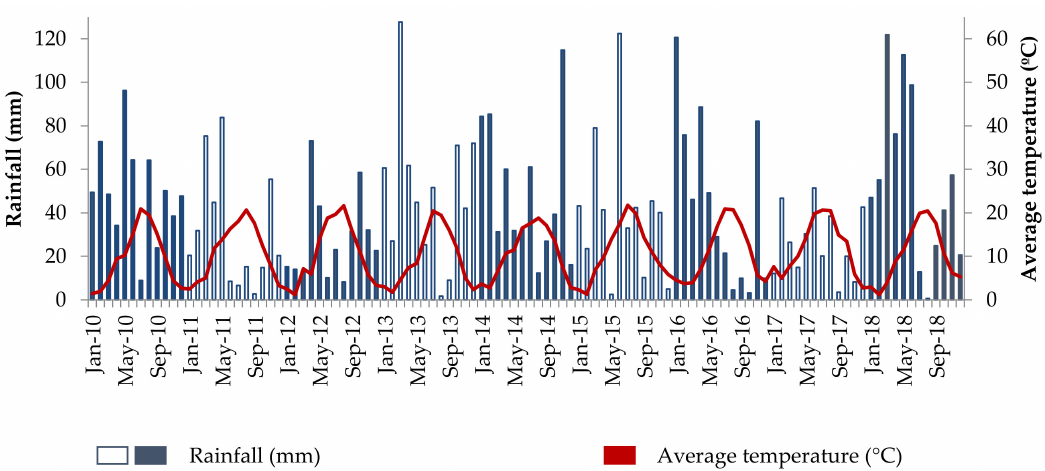
Figure 1. Rainfall and temperature data for Cubo de la Solana fields during the study years. Hollow and filled bars indicate di ff erent consecutive